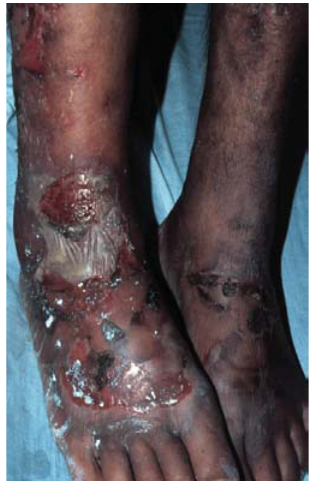
Figure 5 - Tense bullous lesions with purulent content and pellagroid eczematous plaques on the anterior surface of the legs and feet,